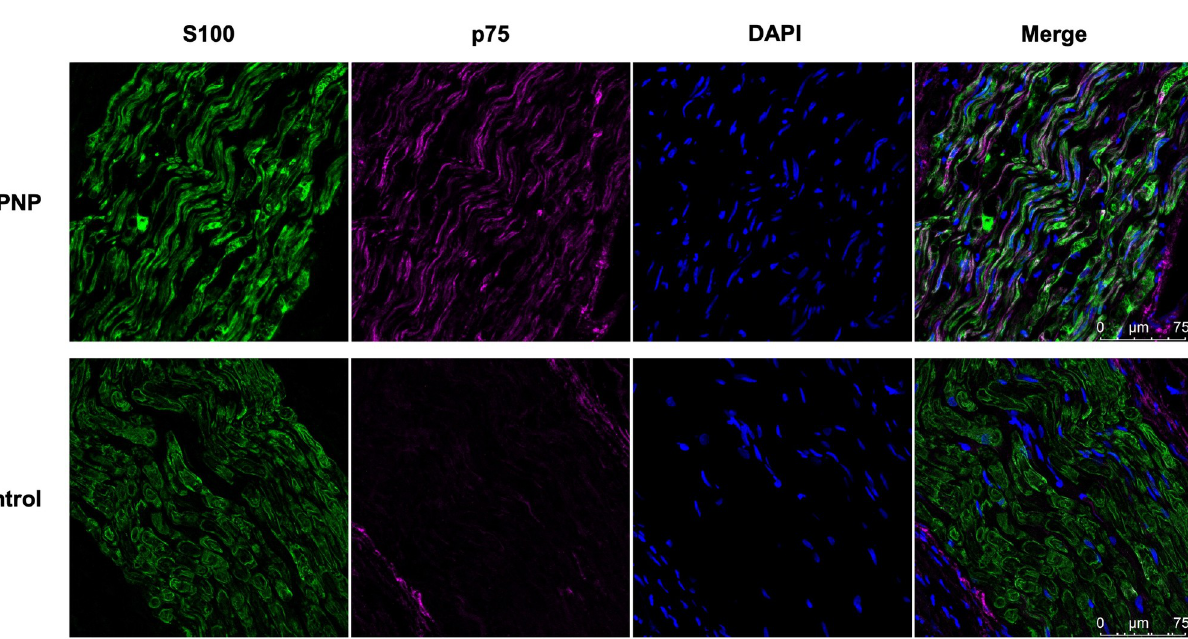
In this study, Schwann cell characteristics and function were assessed in polyneuropathy patients, the majority presenting with axonal polyneuropathy, and compared to neurologically